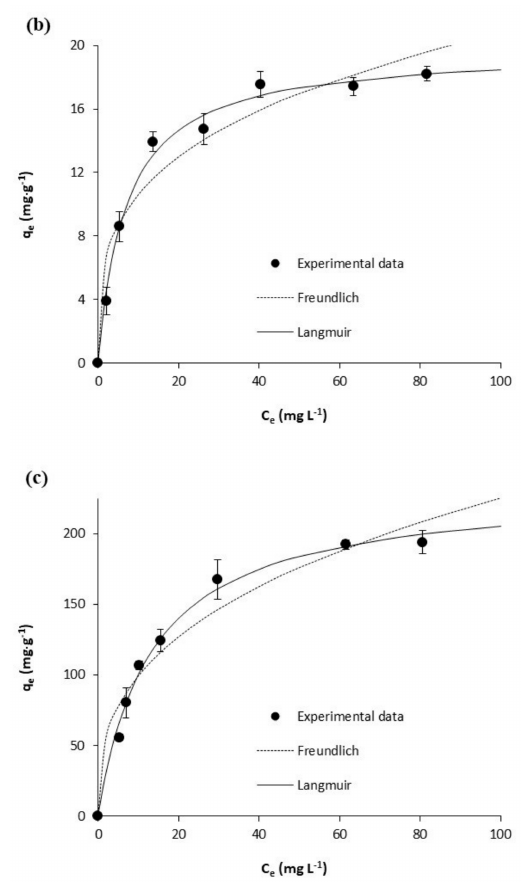
Figure 2. Equilibrium results on the adsorption of diclofenac onto ( a ) Scenedesmus sp. biomass; ( b ) Synechocystis sp. biomass; and ( c ) activated carbon. Experimental data on the equilibrium adsorbed concentration of diclofenac ( q e , mg · g − 1 ) versus the equilibrium diclofenac concentration in the liquid phase ( C e , mg · L − 1 ) are represented together with fittings to the Langmuir and Freundlich equilibrium isotherm models. Notes: error bars stand for standard deviation (N = 3). The scale of the axis has been adjusted for a better visualization of